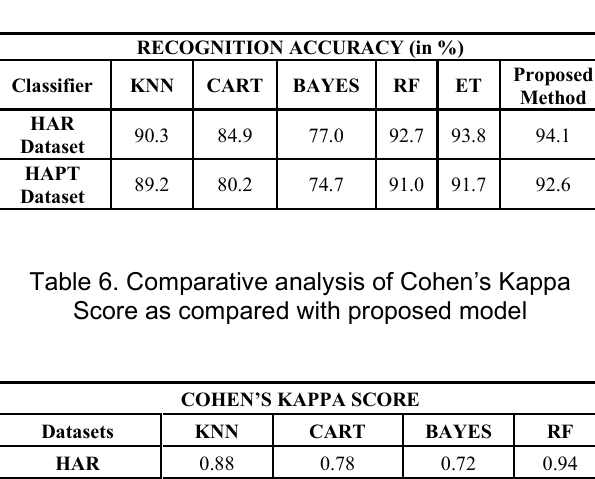
Table 5. Comparative analysis of recognition accuracies of proposed approach with existing classifiers